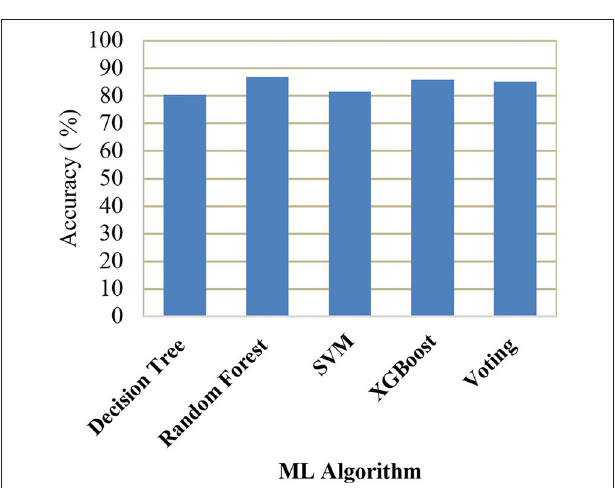
FIGURE 10 | Confusion matrix for SVM.